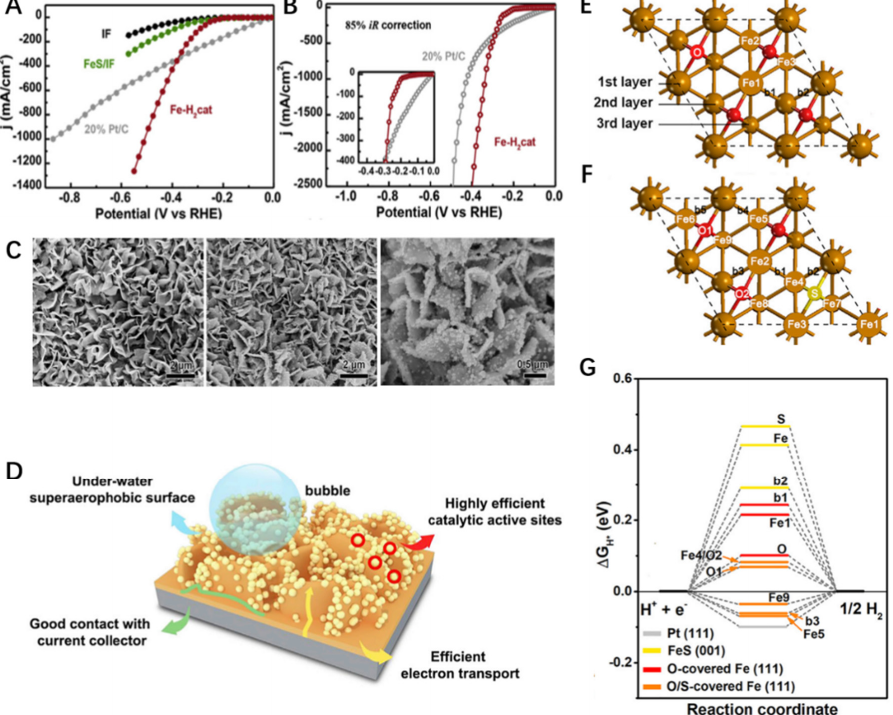
Figure 4. ( A ) Linear sweep voltammetry (LSV) curves of the HER against IF, Pt/C (20 wt %), Fe-H 2 cat and FeS/IF in a 1 M KOH solution (without iR correction). ( B ) LSV curves of Fe-H 2 cat with Pt/C (20 wt %) corrected with 85% iR for the HER. ( C ) From left to right, SEM images of Fe-S/IF, low-magnification SEM images of Fe-H 2 cat, and high-magnification SEM images of Fe-H 2 cat. ( D ) Schematic of the principle of the HER activity enhancement of Fe-H 2 cat. ( E ) Possible H* adsorption locations on the O-covered Fe (111) surface and ( F ) O/S-covered Fe (111) surface. All top positions on the surface (indicated by elemental symbols) and top shallow bridge positions (indicated by “b”) are considered. ( G ) Calculated free energy diagrams for Pt (111), FeS (001), O-covered Fe (111), and O/S-covered Fe (111) surfaces at equilibrium potential for the HER. Reproduced with permission [19], Copyright 2018,